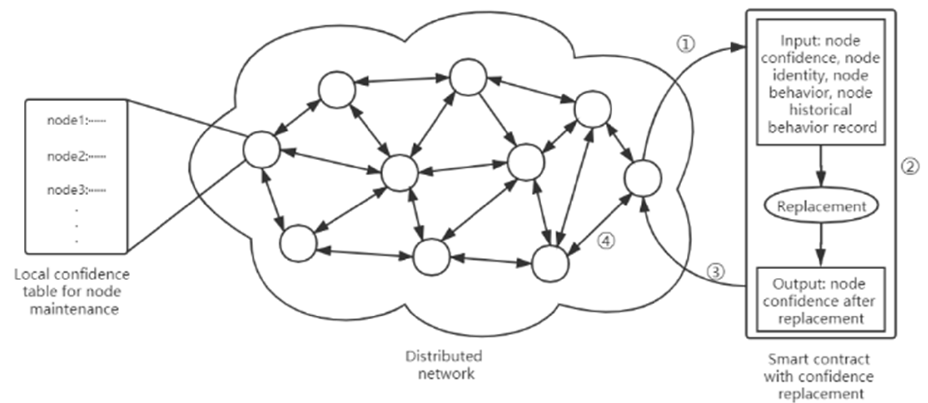
Figure 2. Reputation replacement based on smart contract.